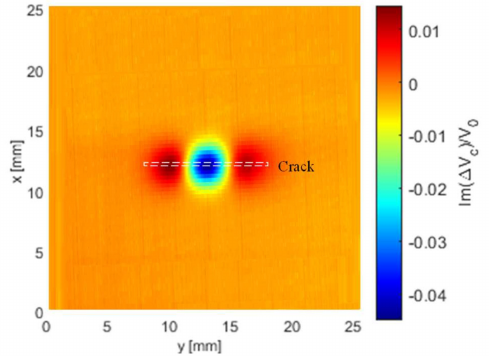
Figure 7. The 2-D imaging of the imaginary part of normalised voltage change (due to the crack) using the T-R sensor (tilt angle ϕ = 0 degree) for the inspection of a surface notch with a depth of 1.6 mm.